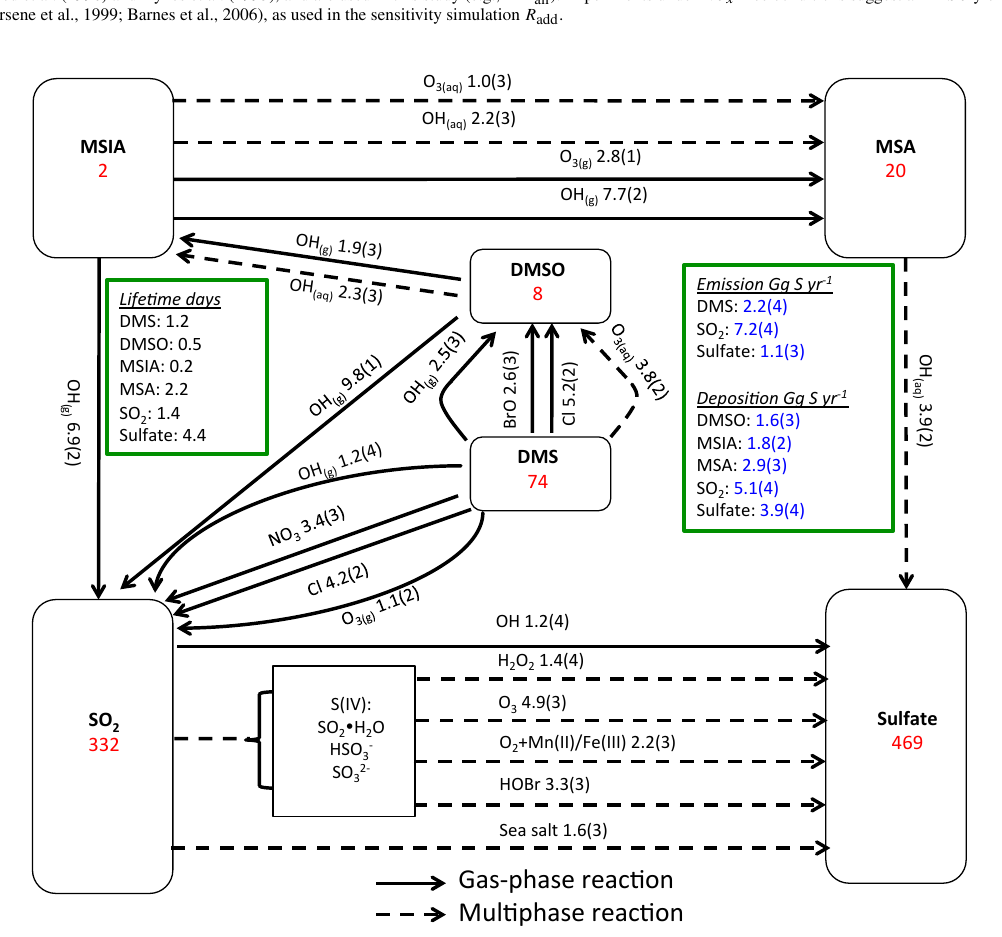
Figure 1. Global sulfur budgets for R all . Inventories (inside the boxes) are in units of GgS. Solid arrows represent gas-phase reactions, while dashed arrows represent aqueous-phase reactions. Production and loss rates above arrows are in units of GgSyr − 1 . Read 1.9(3) as 1 . 9 × 10 3 GgSyr − 1